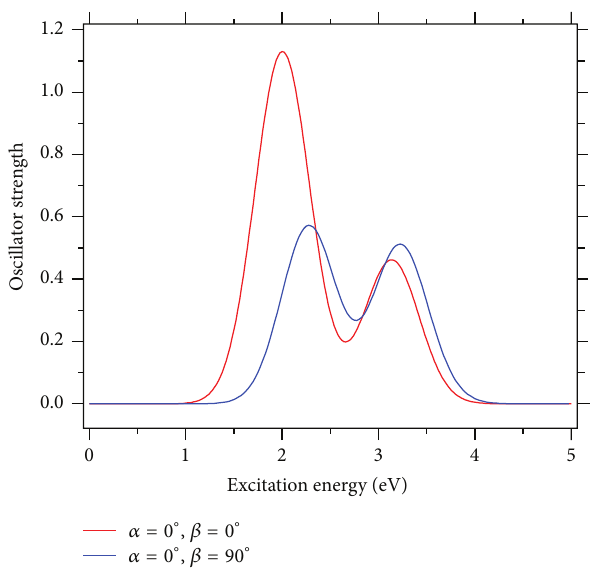
Figure 6: Computed UV/VIS spectra of the BCNDTS molecule at different torsional